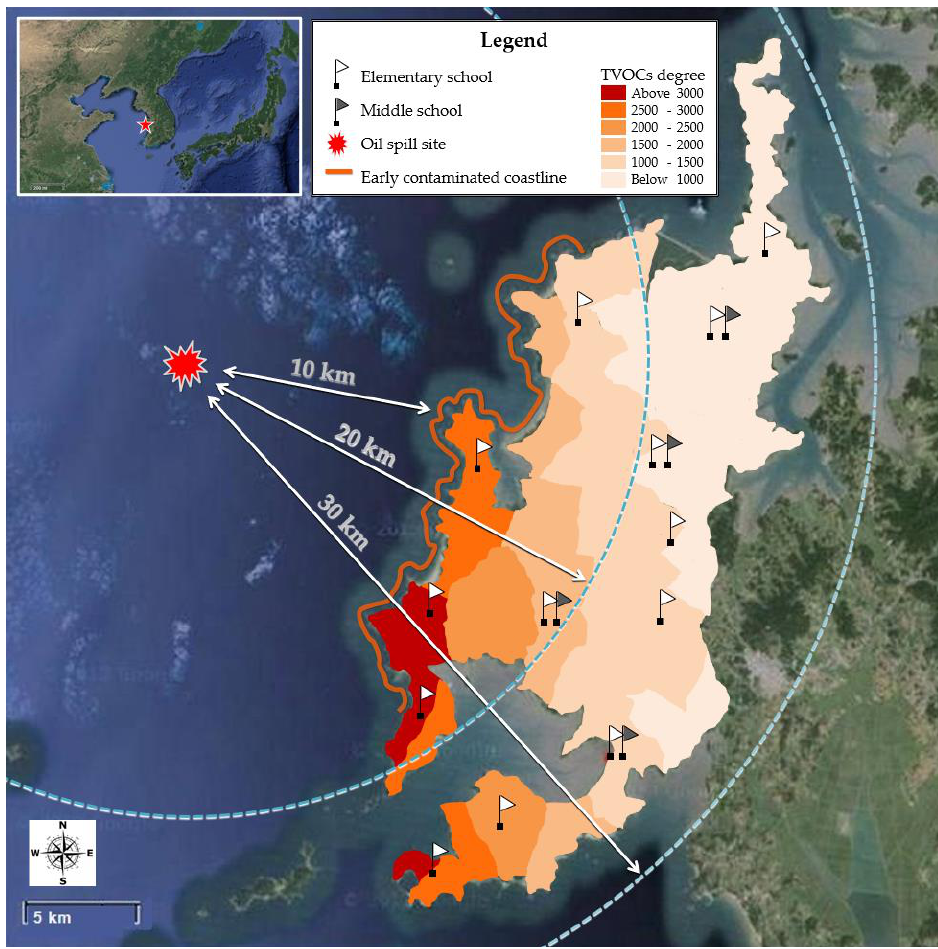
Figure 1. Distribution of TVOCs estimated concentration in the study area.